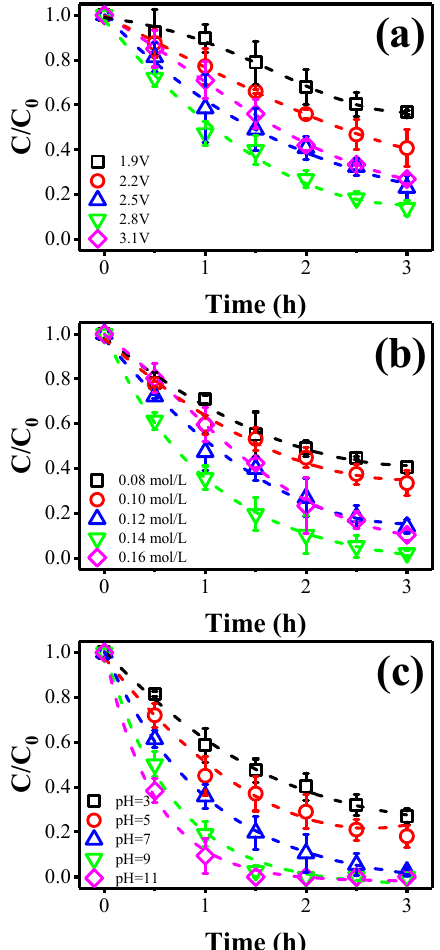
Figure 1. The e ff ect of di ff erent operational factors on the ammonia removal: impact of ( a ) anode Figure 1. The effect of different operational factors on the ammonia removal: impact of ( a ) anode potential, ( b ) [Cl − ] concentration, and ( c ) solution potential, ( b ) [Cl − ] concentration, and ( c ) solution pH.